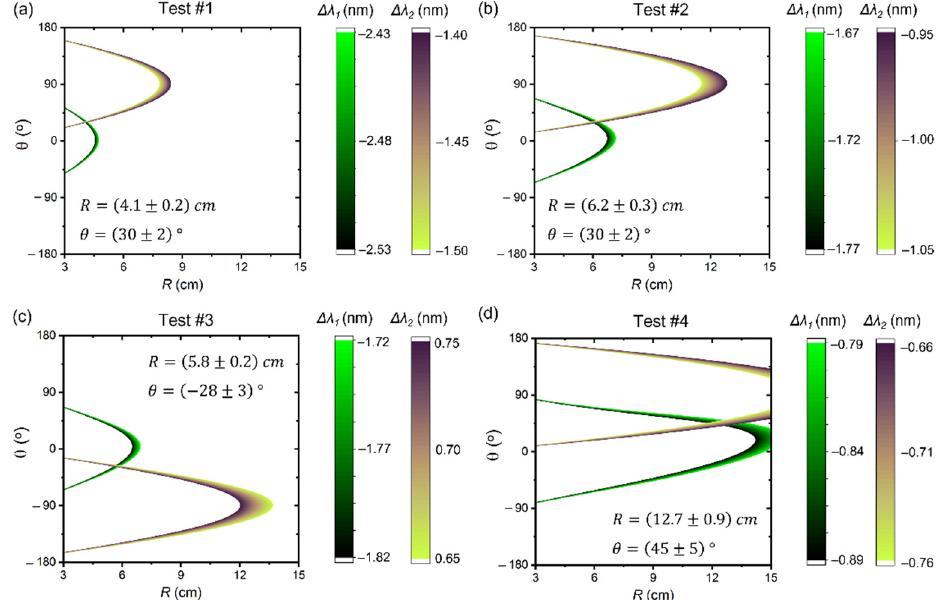
Figure 7. Color plots from calibration for selected ∆ λ 1 and ∆ λ 2 values. The intersecting region between ∆ λ 1 and ∆ λ 2 plots allows the curvature radius and angle expected from the calibration to be obtained. ( a ) Test #1, ( b ) Test #2, ( c ) Test #3, and ( d ) Test #4.